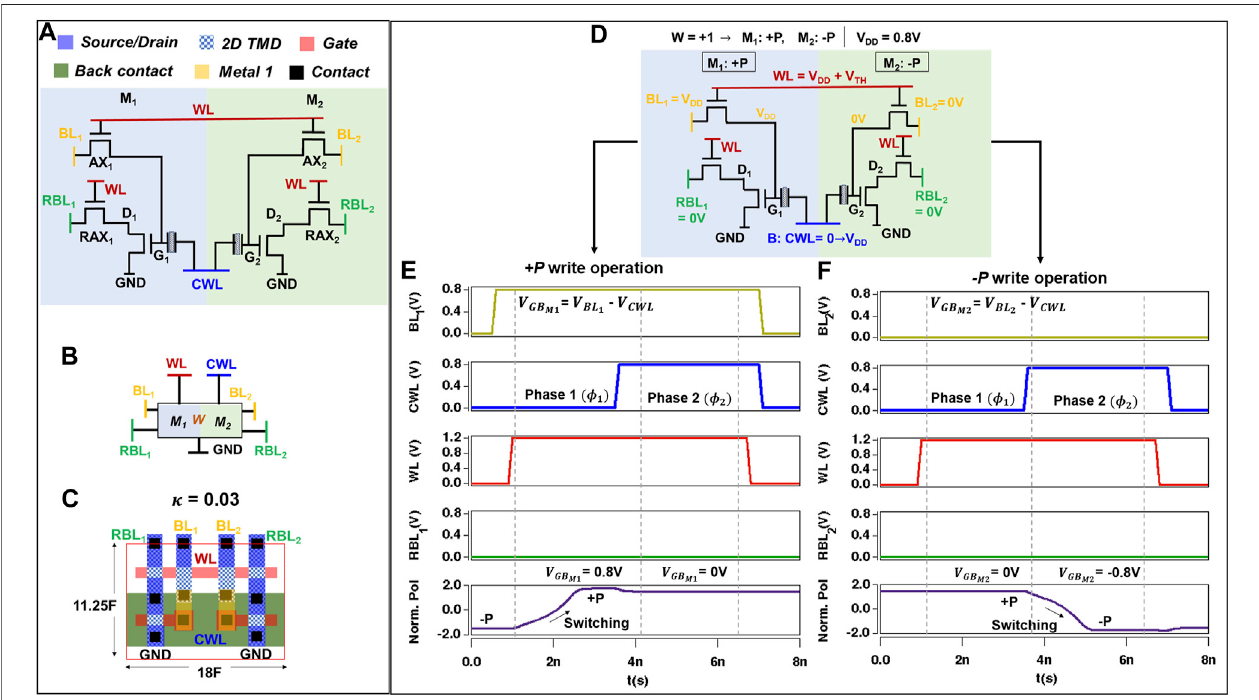
FIGURE 6 | Non-volatile memory cell for STeP-CiM showing (A) Schematic illustration, (B) symbol, and (C) layout. (D) Schematic representation of the STeP-CiM cellwithanexampleofbiasesforwriteoperation(ternary1).Two-phasewriteoperationdepictingin (E) − P → +P polarizationswitchingwhen V GB =0.8 V > V C and (F) + P → − P polarization switching when V − 0.8 V < − V − P states being written to M GB = C . + P and 1 and M 2 constitute ternary storage of W = +1.